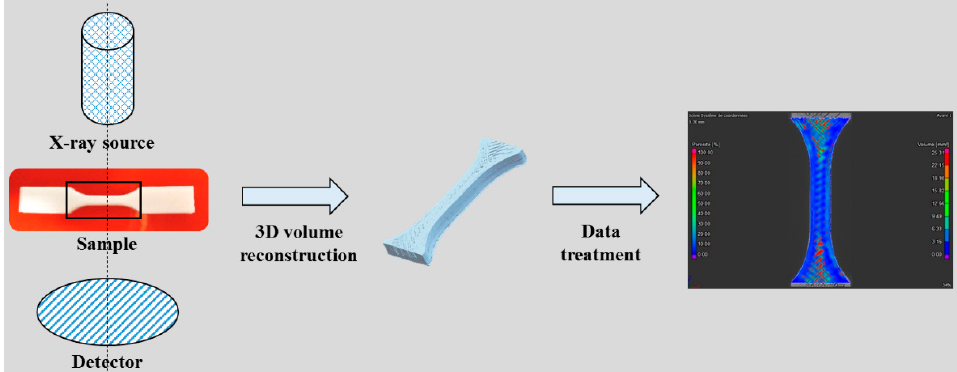
Figure 2. Schematic representation of the microtomographic